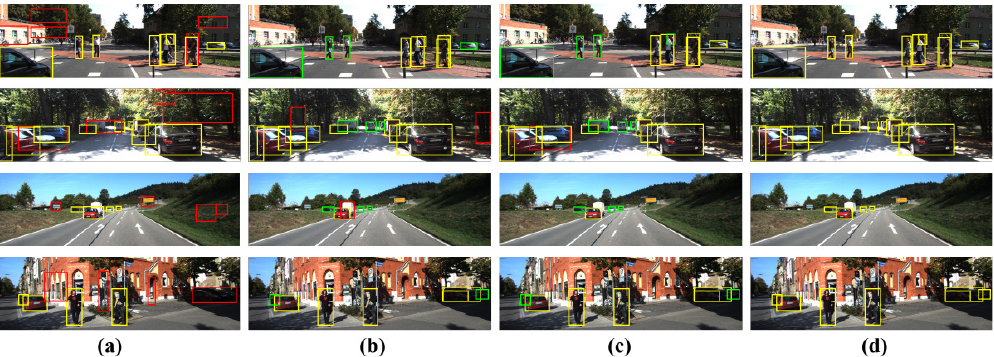
Figure 6. Qualitative results of our proposed method. We projected the classification results on the image data. ( a ) The results of CCD unary classifier. ( b ) The results of LiDAR unary classifier. ( c ) The results of model 17 . ( d ) The results of proposed method. Each box indicates the following: yellow box: correctly-detected and -classified objects; red box: failures; green box: un-detected